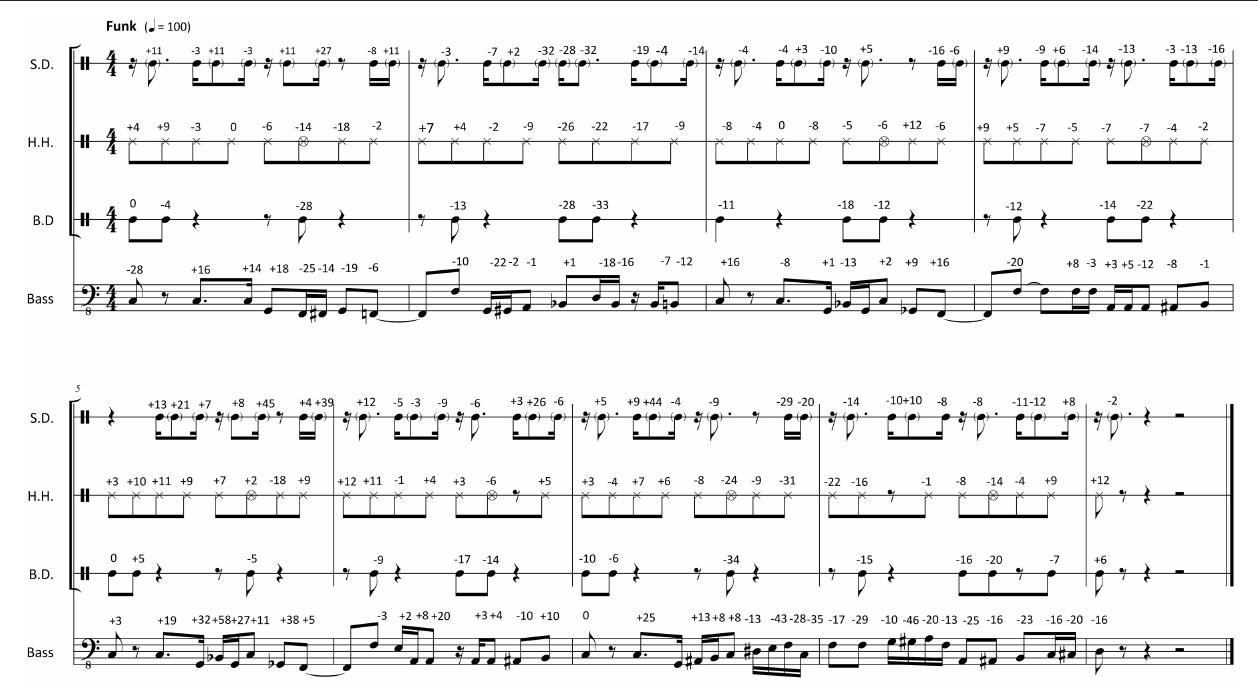
FIGURE 2 | Transcription of the recorded 8-bar Funk pattern used as a basis for the timing manipulations. Originally performed timing deviations from metronomic time are indicated in milliseconds (negative numbers, event is ahead of the metronome; positive number, event sounds later than the metronome); S.D., snare drum; H.H., hi-hat cymbal; B.D., bass